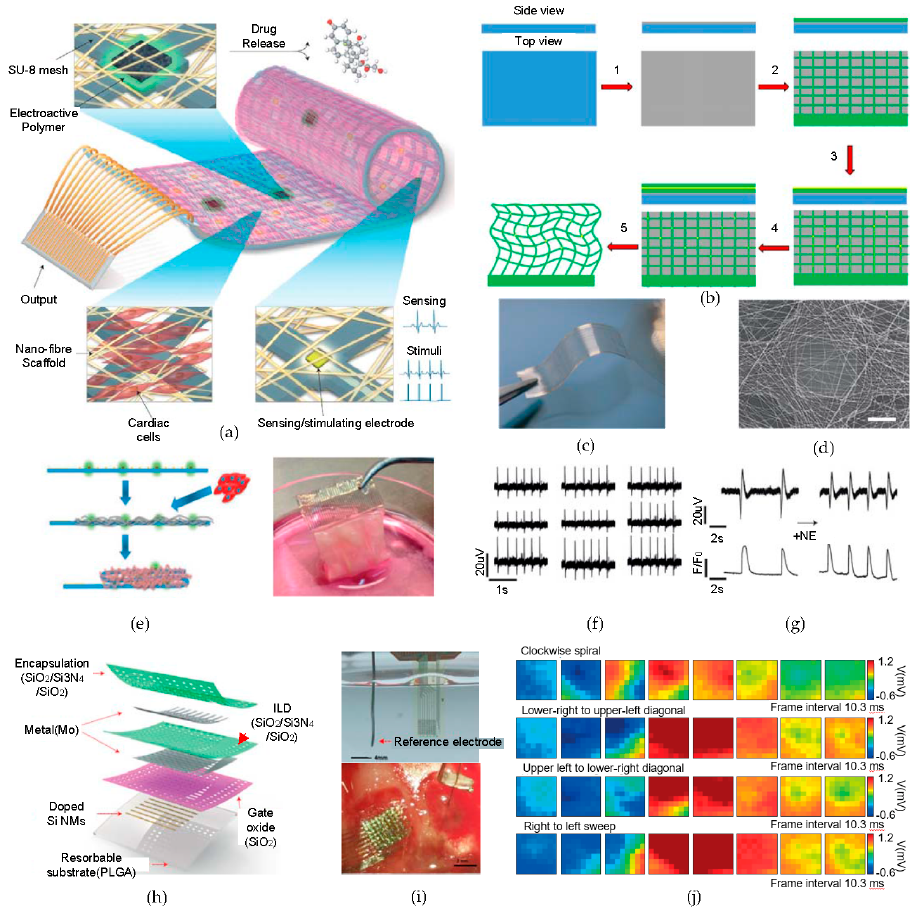
Figure 4. Multifunctional electronic system with biomaterial-based three-dimensional (3D) scaffold cardiac patches/multiplexed bio-resorbable silicon-based design for brain mapping. ( a ) Designed